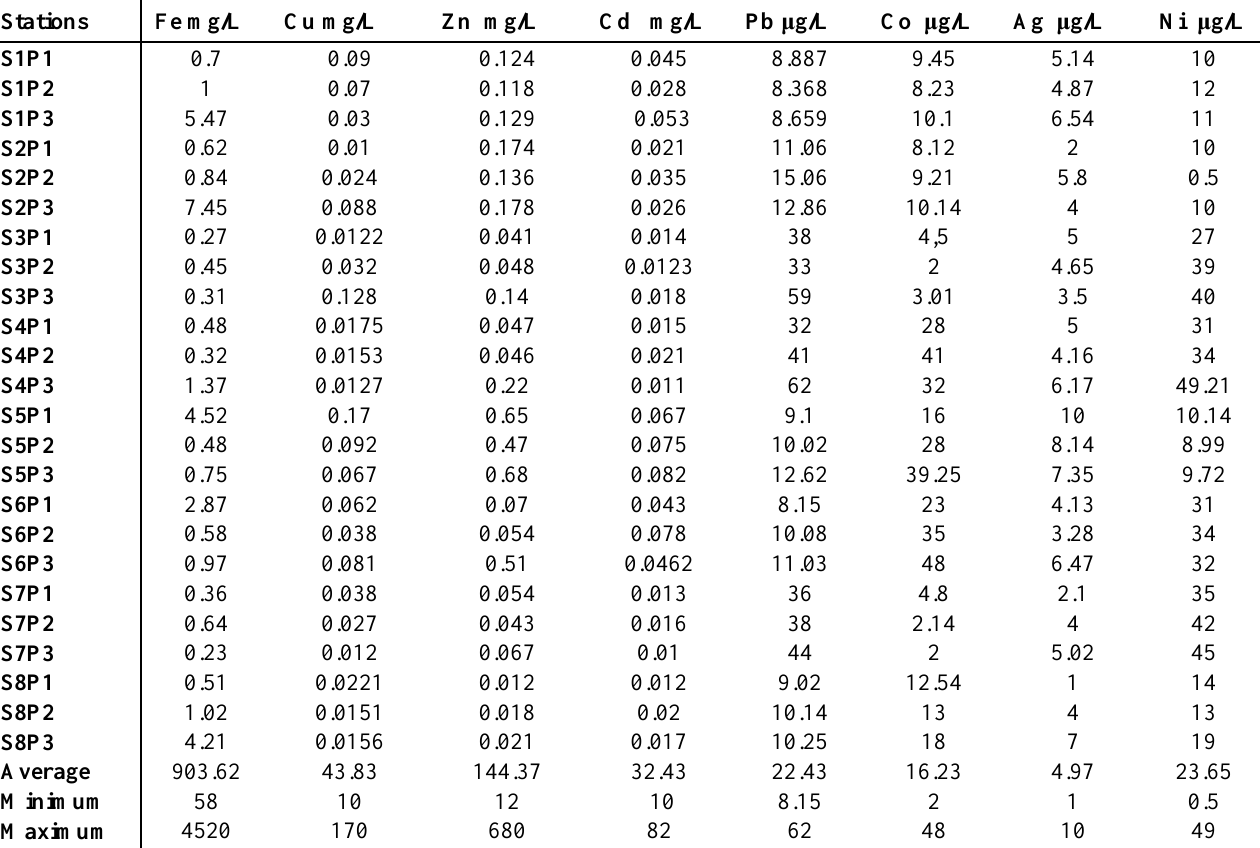
Table 4. Descriptive statistics of eight metals (expressed as total metal) measured in the waters of ten sites in Reghaia Lake.